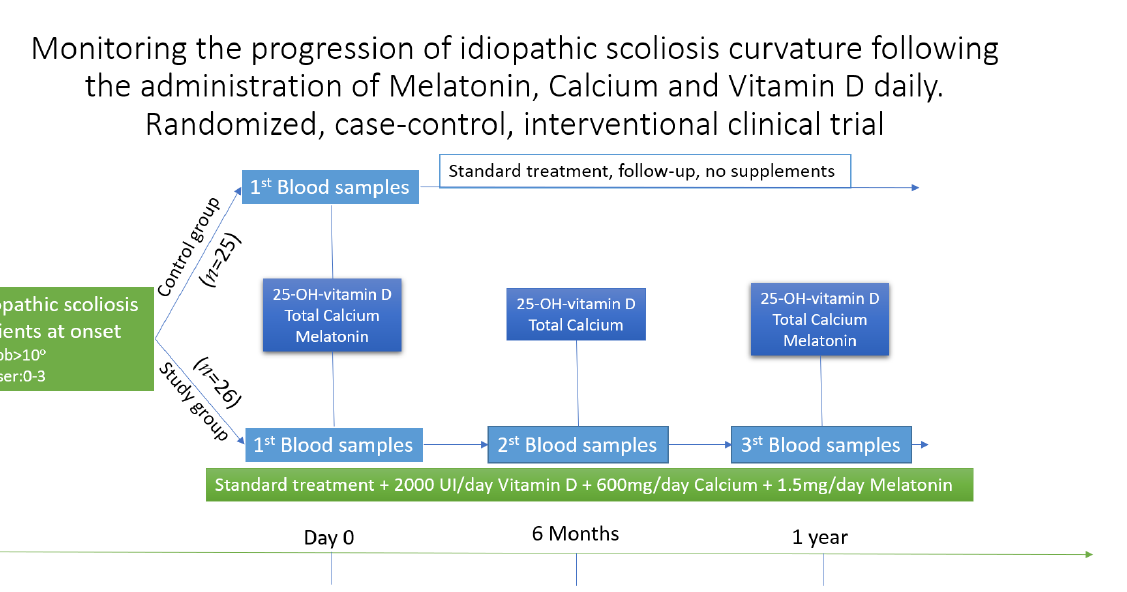
Figure 1. Follow-up and analysis table for patients in the study “Monitoring the progression of idiopathic scoliosis curvature following the administration of Melatonin 1.5 mg/daily, Calcium 600 mg/daily and Vitamin D 2000 UI/daily. The randomized, case–control, interventional clinical trial”. Initially, when enrolling in the study, both groups did all three tests, then, at six months and one year, only the study group repeated the tests. After six months, the study group repeated only the blood samples for vitamin D and calcium, being only a stage verification. * Other requirements for inclusion were Cobb angle of more then 10 0 and a Risser score between 0 and 3.